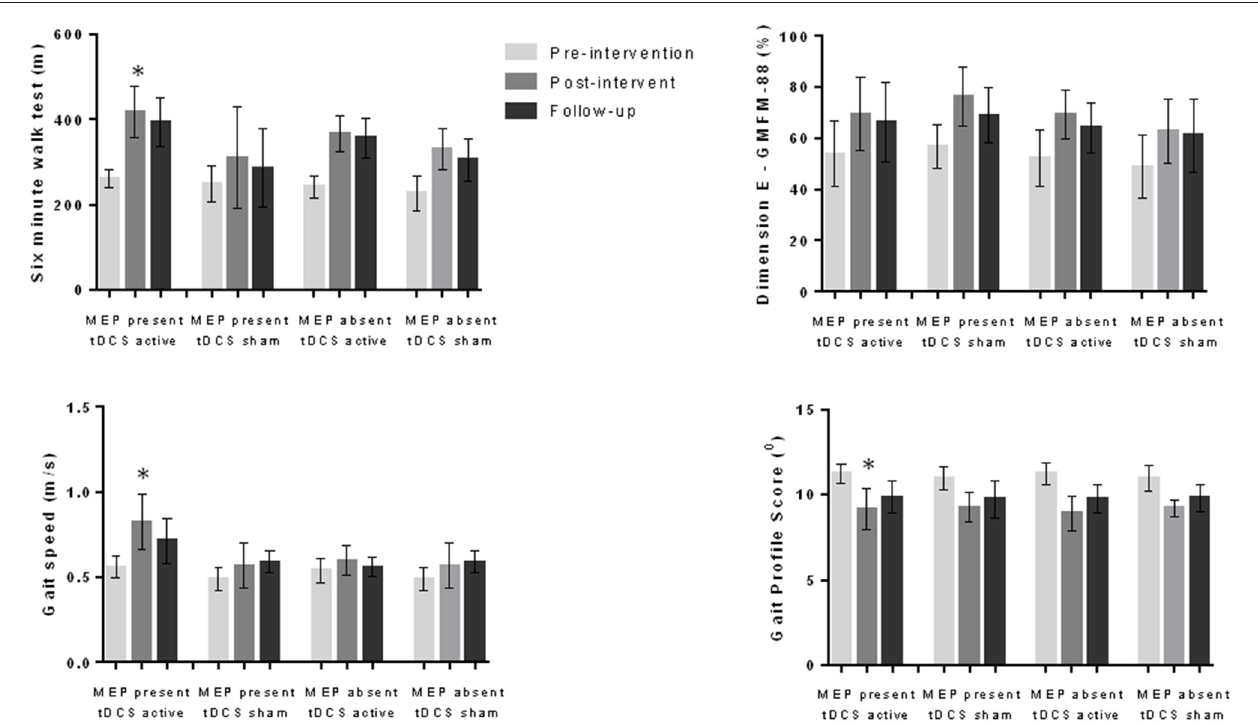
FIGURE 1 | Data for six-minute walk test (6MWT), gait speed, gait profile score and dimension E of the gross motor function measure (GMFM-88) during pre-intervention, post-intervention and follow-up evaluations considering motor evoked potential (MEP) present and absent as well as active and sham transcranial direct current stimulation (tDCS; 56 children). Children with MEP present at pre-intervention evaluation and who received active tDCS demonstrated better results at the post-intervention evaluation in comparison to other groups for 6MWT, gait speed and gait profile score. ∗ p < 0.05 analysis of variance (ANOVA) followed by Bonferroni post hoc